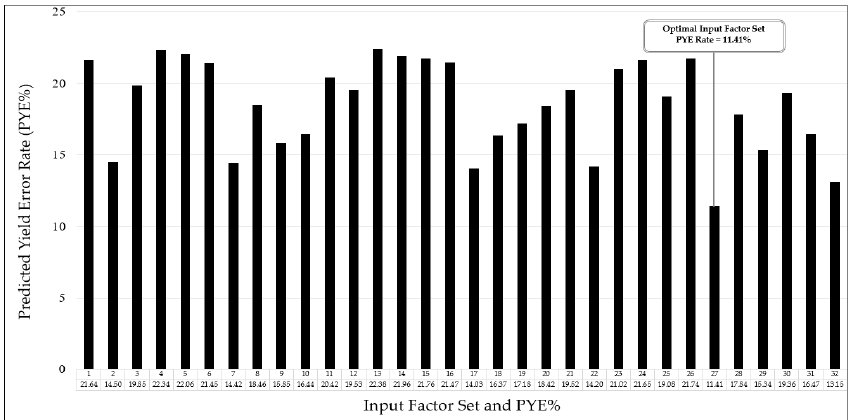
Figure 13. IF sets and PYE rates from the IF Design Process. IF set#27 had the lowest PYE